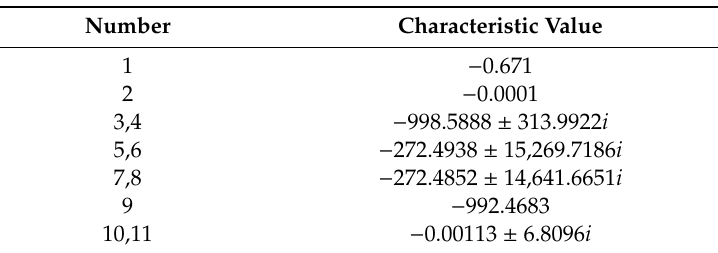
Table 2. Eigenvalues of the microgrid. Table 1. Stable operation points of the systems.